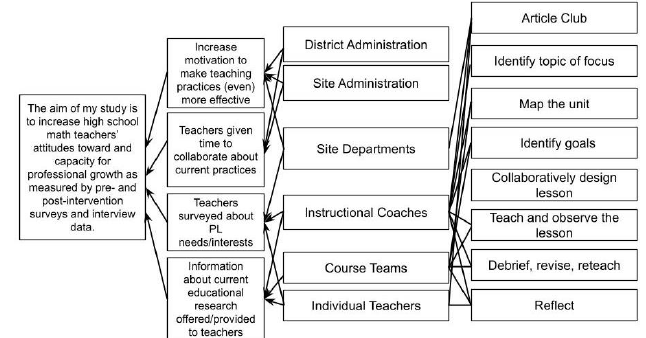
Figure D2. Kerry’s Revised Driver Diagram